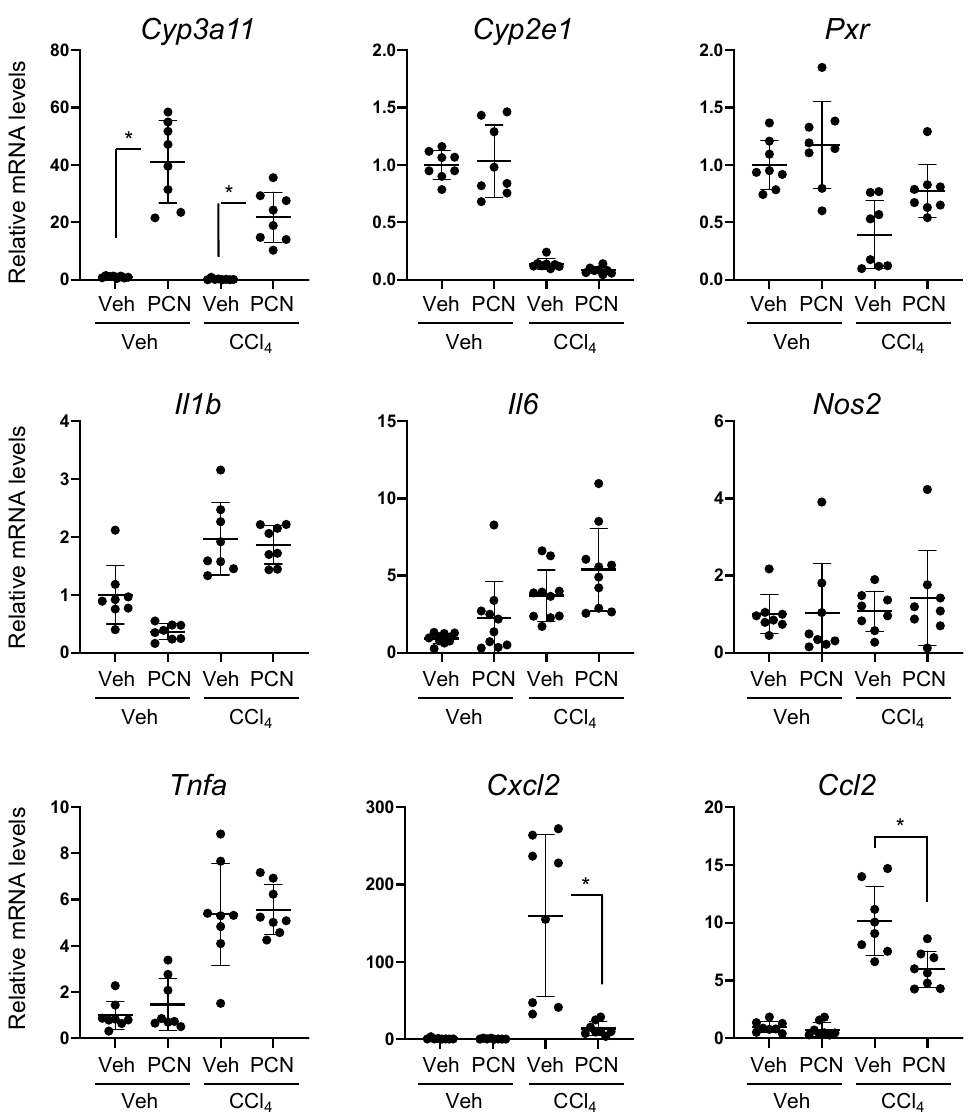
Figure 2. E ff ect of PCN treatment on the hepatic mRNA levels in CCl 4 -treated mouse. The total RNA from the mouse livers illustrated in Figure 1 was subjected to quantitative reverse transcription polymerase chain reaction (qRT-PCR). The mRNA levels of the target genes were normalized to 18S rRNA levels and are shown as relative values with that of the vehicle-treated mice as 1. Data are presented as mean ± SD with the plots of individual mouse data ( n = 8). * p < 0.05 (Student’s t